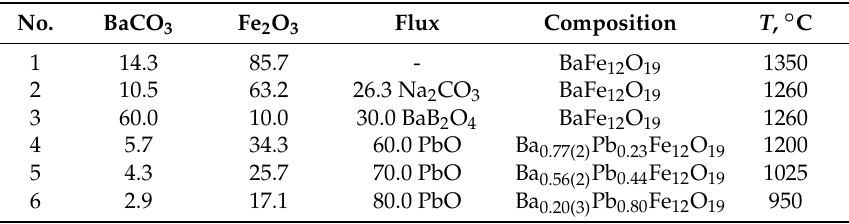
Table 1. Initial molar ratios of charge compositions (at %) and maximum temperatures of the different crystal growth experiments. Resulting compositions originate from full structure refinements based on single crystal X-ray diffraction intensity